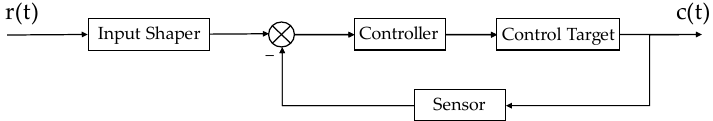
Figure 10. Frame diagram of the input shaping system.